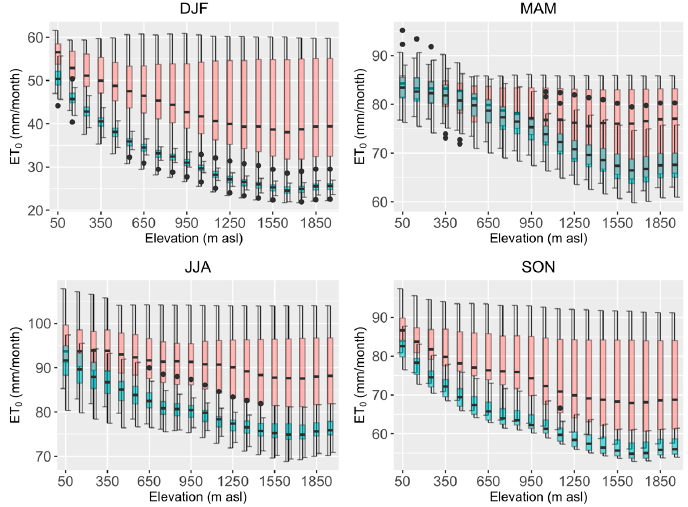
Figure 7. Elevational changes in average monthly ET 0 in mm/month for each season: DJF (December, January, and February), MAM (March, April, and May), JJA (June, July, and August), and SON (September, October, and November). Red and blue box plots represent OBS and EXT, respectively. Furthermore, focusing on the third quartile, the decreasing trend with elevation is not captured by the reference crop ET rates derived from the OBS data. These results indicate that the reference crop ET rates based on the EXT data better reflect the climate characteristics in regions with high elevations, suggesting that spatial interpolation using gap-filled site observations performs better than without the gap-filling process. Hereafter, only the results based on the EXT data are presented. The decreasing trend is present only up to 1500 m a.s.l., and no trend is observed above this level. We therefore develop a linear model between the reference crop ET values and elevation for elevations below 1500 m a.s.l. in different seasons (Table 2). All of the linear models show an adjusted R 2 value greater than 0.94. In winter (summer), the magnitude of reference crop ET is relatively small (large), and its rate of decrease with elevation is relatively large (small). Table 2. Relationships between ET 0 based on extended data and elevations below 1500 m a.s.l. Season